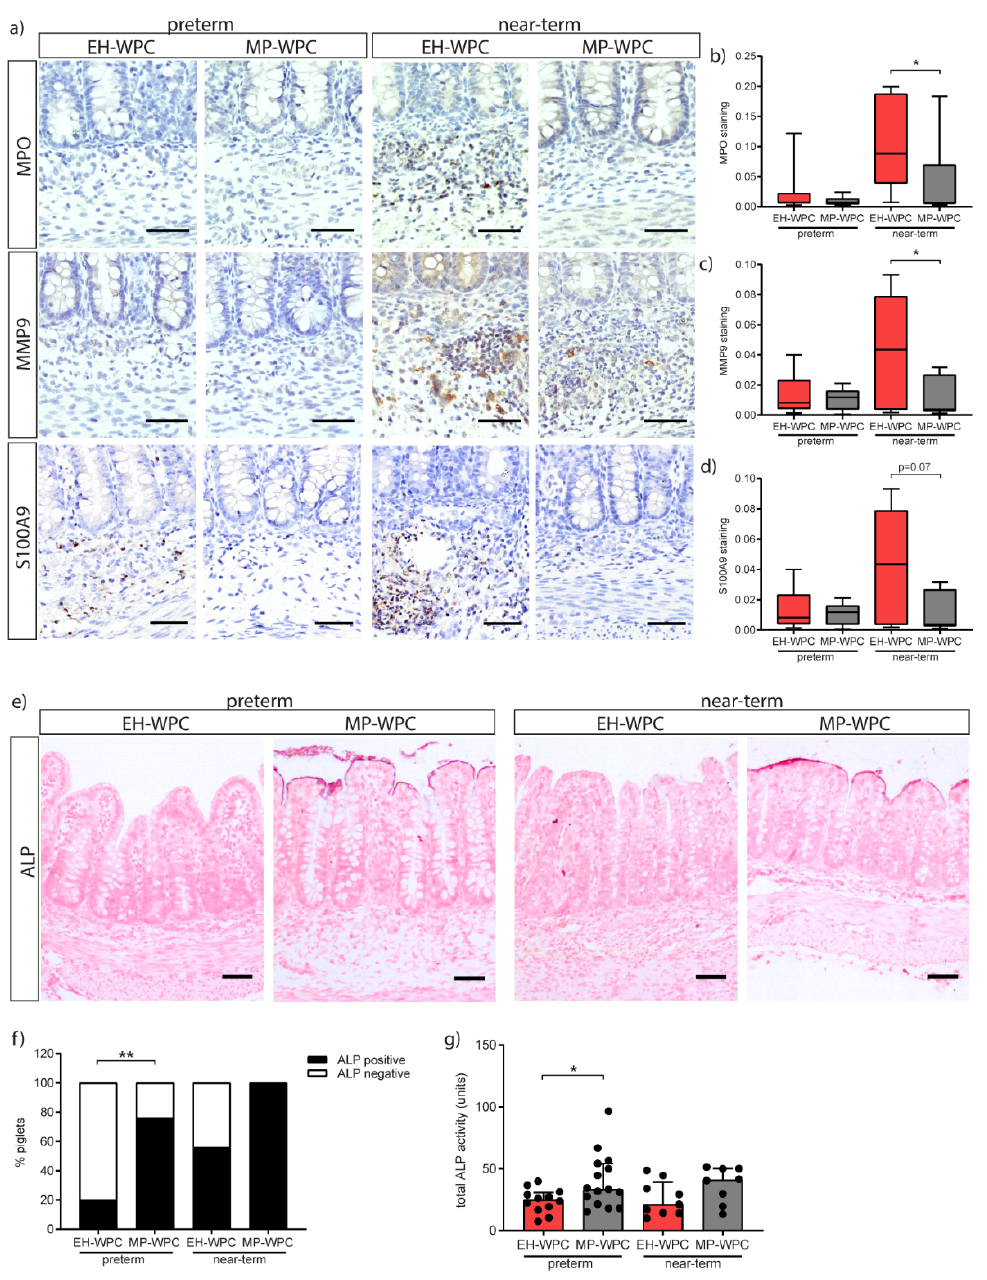
Figure 3. Innate defense in the colon is influenced by MP ‐ WPC and gestational age . ( a ) detection of neutrophils by immunohistochemistry in colon tissue, with relative staining intensity of ( b ) MPO, ( c ) MMP9 and ( d ) S100A9 quantified by ImageJ analysis. ( e ) iALP brush border activity on colon tissue slides was determined with NBT / BCIP conversion and ( f ) number of piglets with iALP positive brush border was quantified. ( g ) Total iALP enzyme activity ( µ g pNPP · mg protein · min − 1 ) determined on protein level in colon tissue homogenates and content. Values are median ± IQR, * p ≤ 0.05 ** p ≤ 0.01. Scalebar equals 50 μ m.